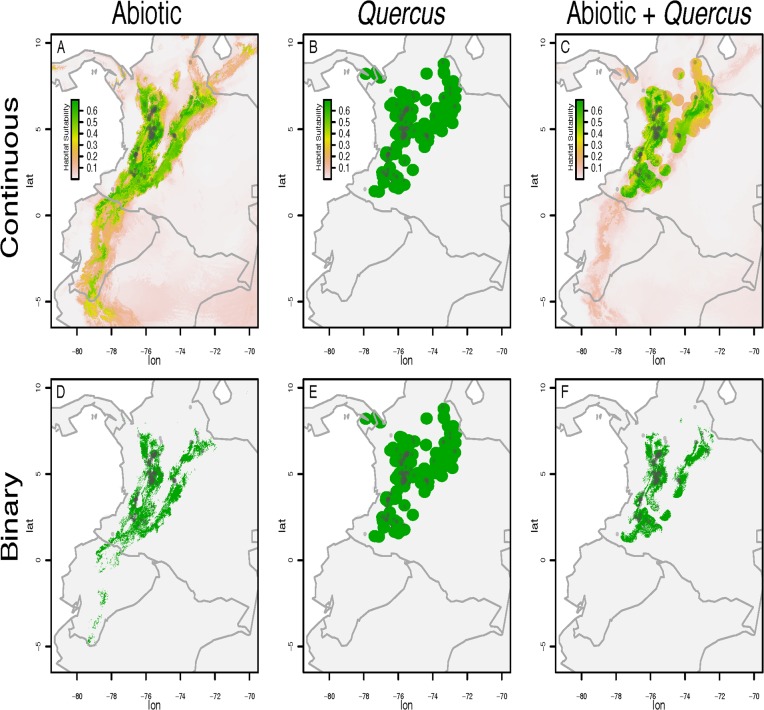
Species distribution models generated for Acorn Woodpecker in northern Andes.Habitat suitability is shown as a continuous variable, in which green colors indicate highly suitable habitat, with (A) abiotic variables alone, (B) Quercus presence alone, and (C) abiotic variables + Quercus presence. We converted continuous measures of habitat suitability into binary presence and absence models by setting the threshold to the value that maximizes the parameter Kappa, which is an index of model performance. Binary conversions were done for (C) abiotic variables alone and (D) abiotic variables in addition to presence of Quercus. Excluding Quercus occurrence points generated species distribution models that over-predict the occurrence of Acorn Woodpeckers in South America.